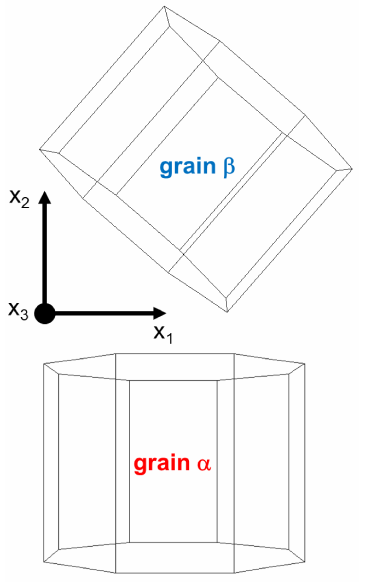
Figure 3. Orientation of the hexagonal cell for the two grains. Their orientations correspond to [ 0001 ] (cid:107) [ 010 ] [ 10¯10 ] (cid:107) [ 001 ] ( C ) ( G ) and ( C ) ( G ) for grain α and for grain β , with ( C ) the crystal frame and ( G ) the global